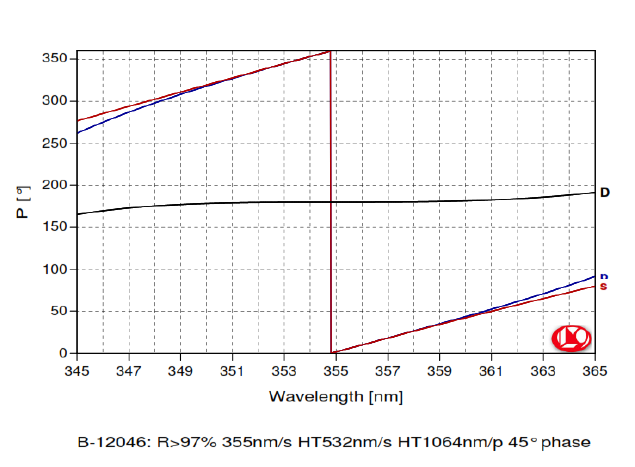
Figure 2: Retardation of the two mirrors in the emitting optics.